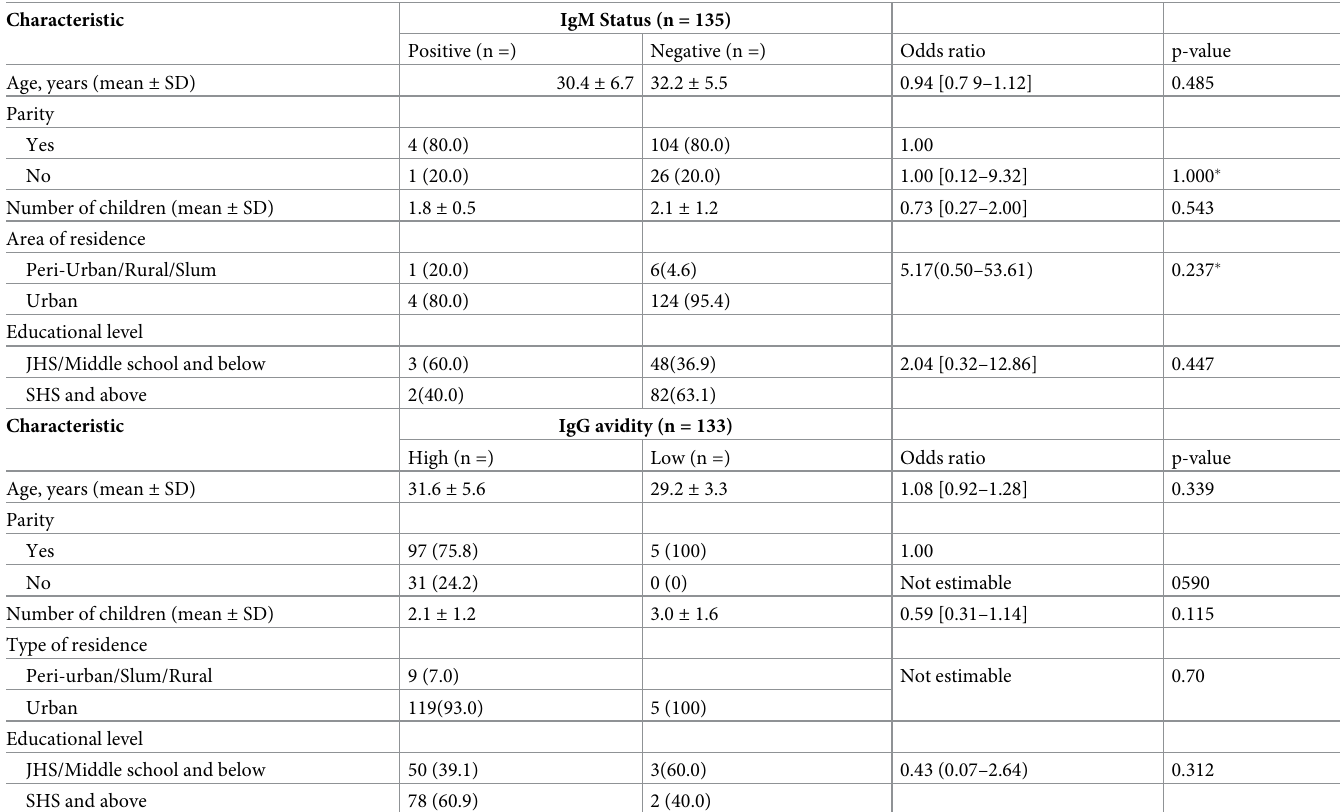
Table 5. Factors associated with IgM positivity and IgG avidity in study